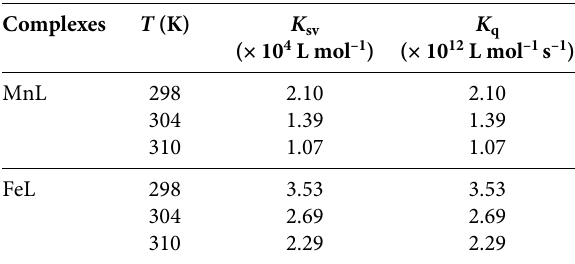
Table 1: K sv and K q values of MnL and FeL complexes Complexes